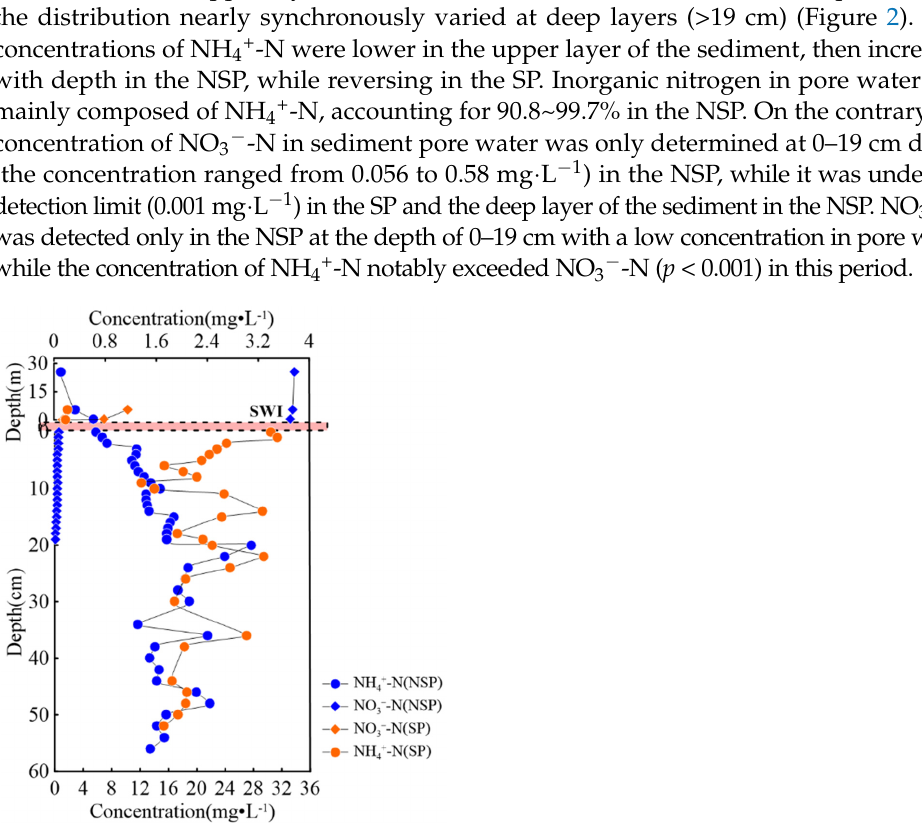
Figure 2. Characteristics of the vertical distribution of inorganic nitrogen in sediment pore water.